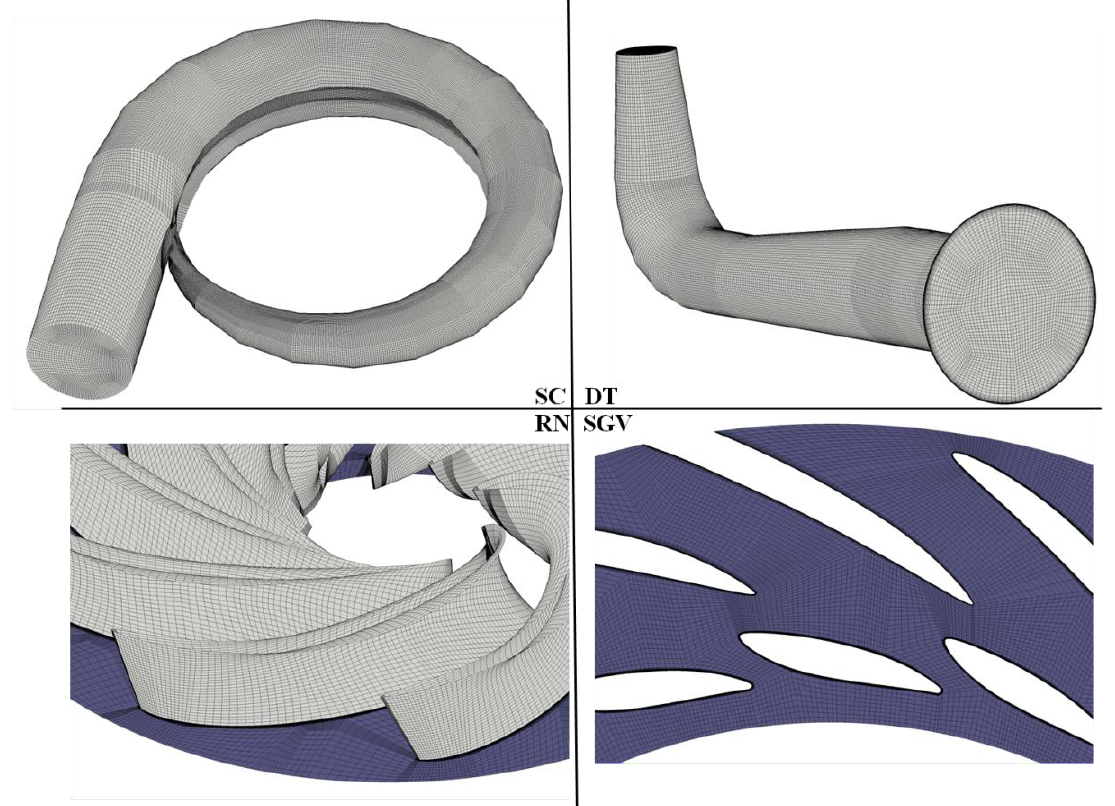
Figure 3. Grids detailed information.